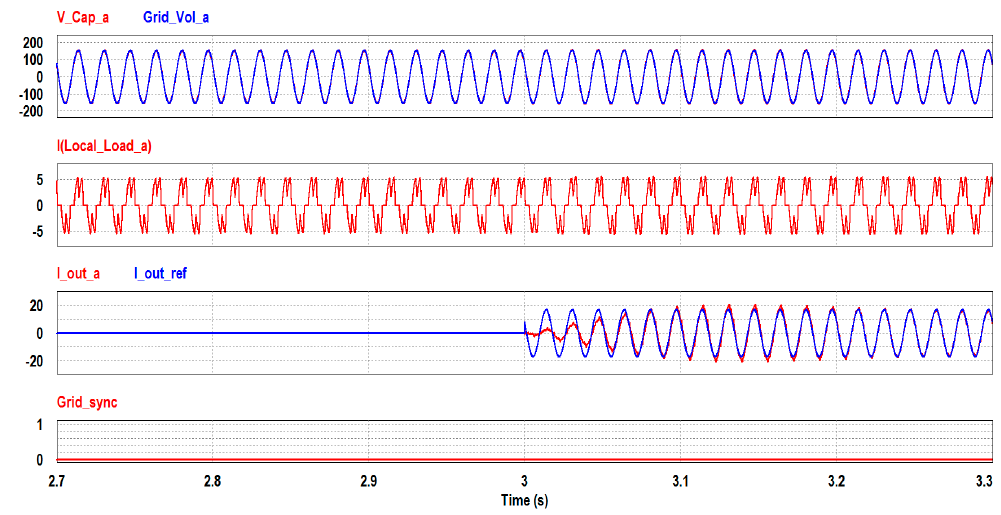
Figure 16. Simulation results when the mode changes from SBGC to GC (Grid Connected mode) in Case IV. (From top to bottom: Measured a -phase inverter output voltage and grid voltage, a -phase local load current, grid current, and GS status signal).